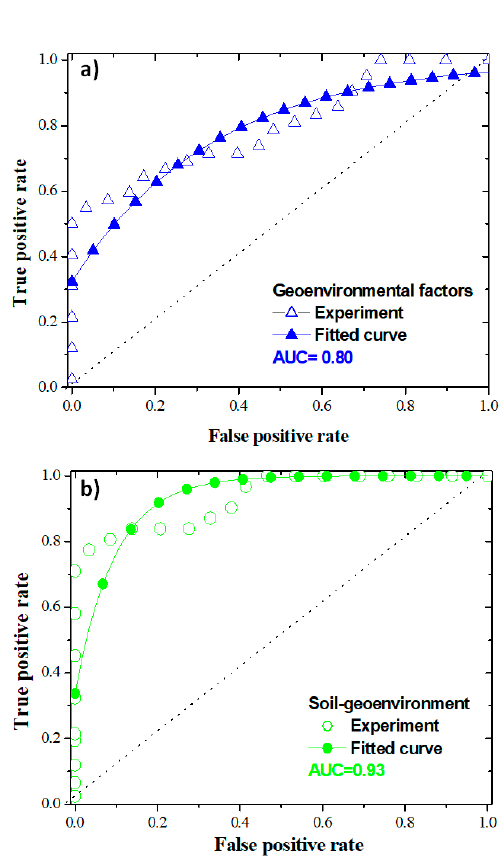
Figure 12. ROC curves for: ( a ) Model based on geo-environmental factors only, ( b ) model based on soil geomechanical and geo-environmental